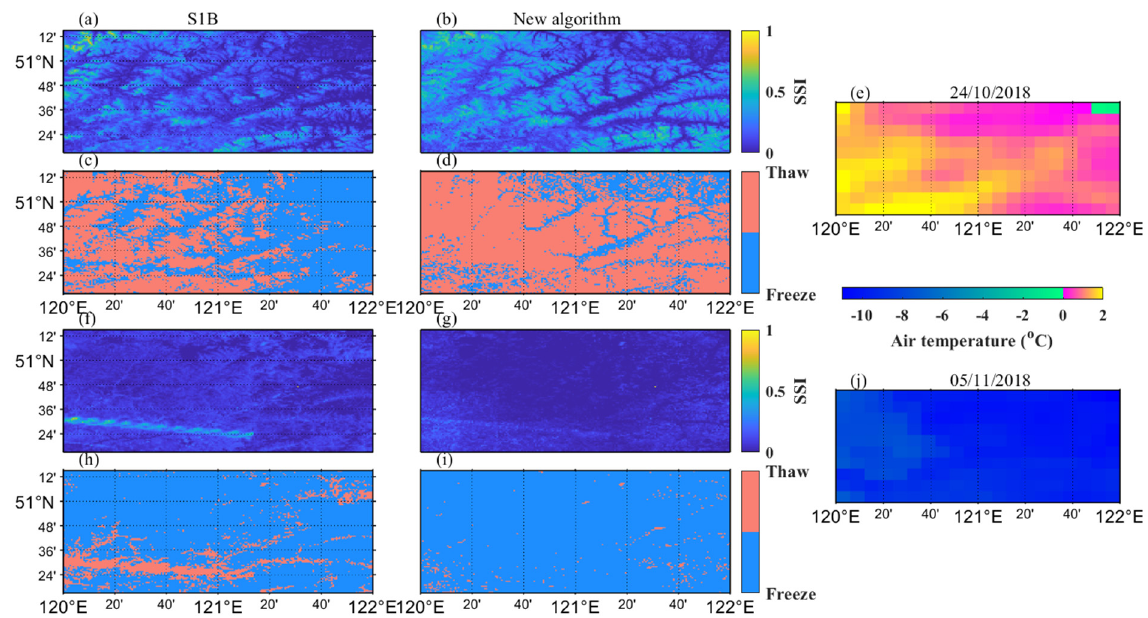
Figure 12. Comparison examples of the spatial distribution of SSI S1B , SSI new , the F/T state retrieved from the SSI S1B , SSI new , and the ERA5-land air temperature over Genhe watershed on 24 October 2018, 5 November 2018, respectively. (SSI S1B : ( a , f ); SSI new : ( b , g ); F/T S1B : ( c , h ); F/T new : ( d , i ); ERA5-land air temperature: ( e , j ).